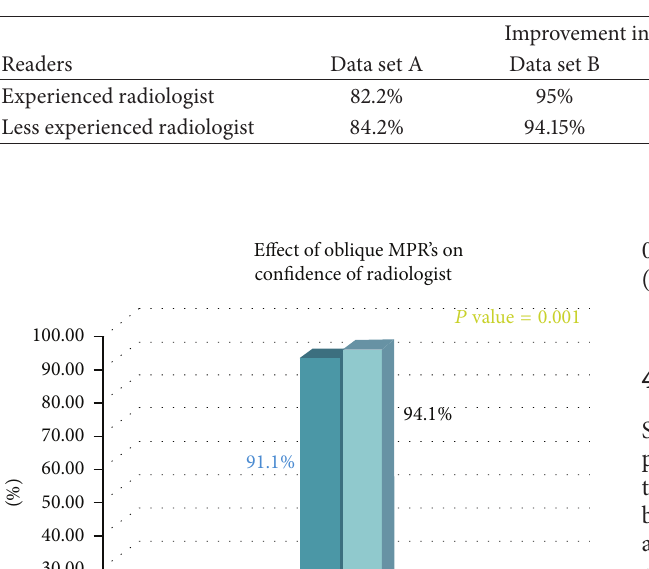
Table 2: Improvement in accuracy of detecting point of transition after using data set B.